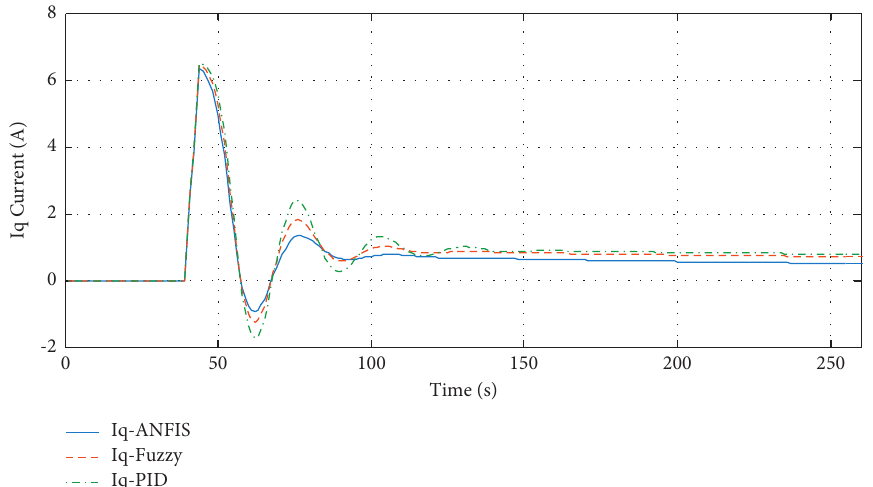
Figure 16: q-axis current of all three ANFIS, Fuzzy. and PID controllers, in “step” reference input